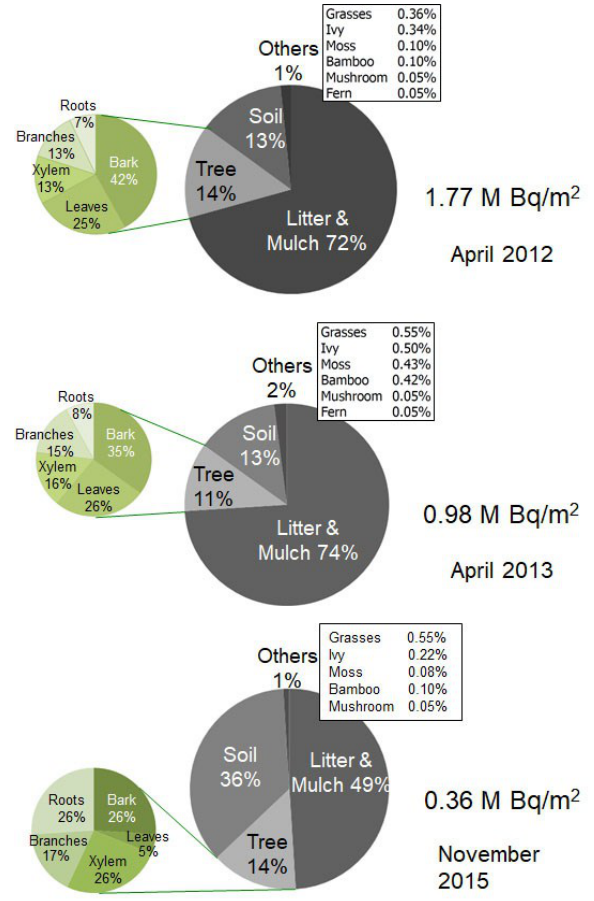
Figure 3. Distribution of radiocesium ( 134 Cs and 137 Cs) in the forest field (Figure 1: area number 2) from April 2012 to November 2015 after the nuclear plant accident. Each percent content represents the mean value of three independent fractions, with individual percentage values varying from the mean by less than 1.1%.